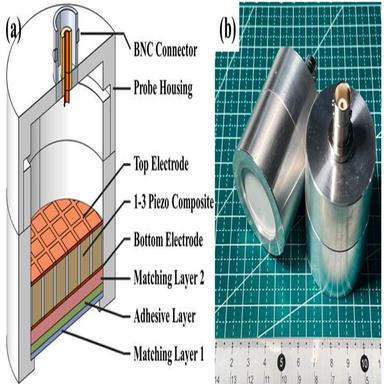
Air-coupled ultrasonic transducer diagram (a) Schematic representation and (b) Physical prototype.